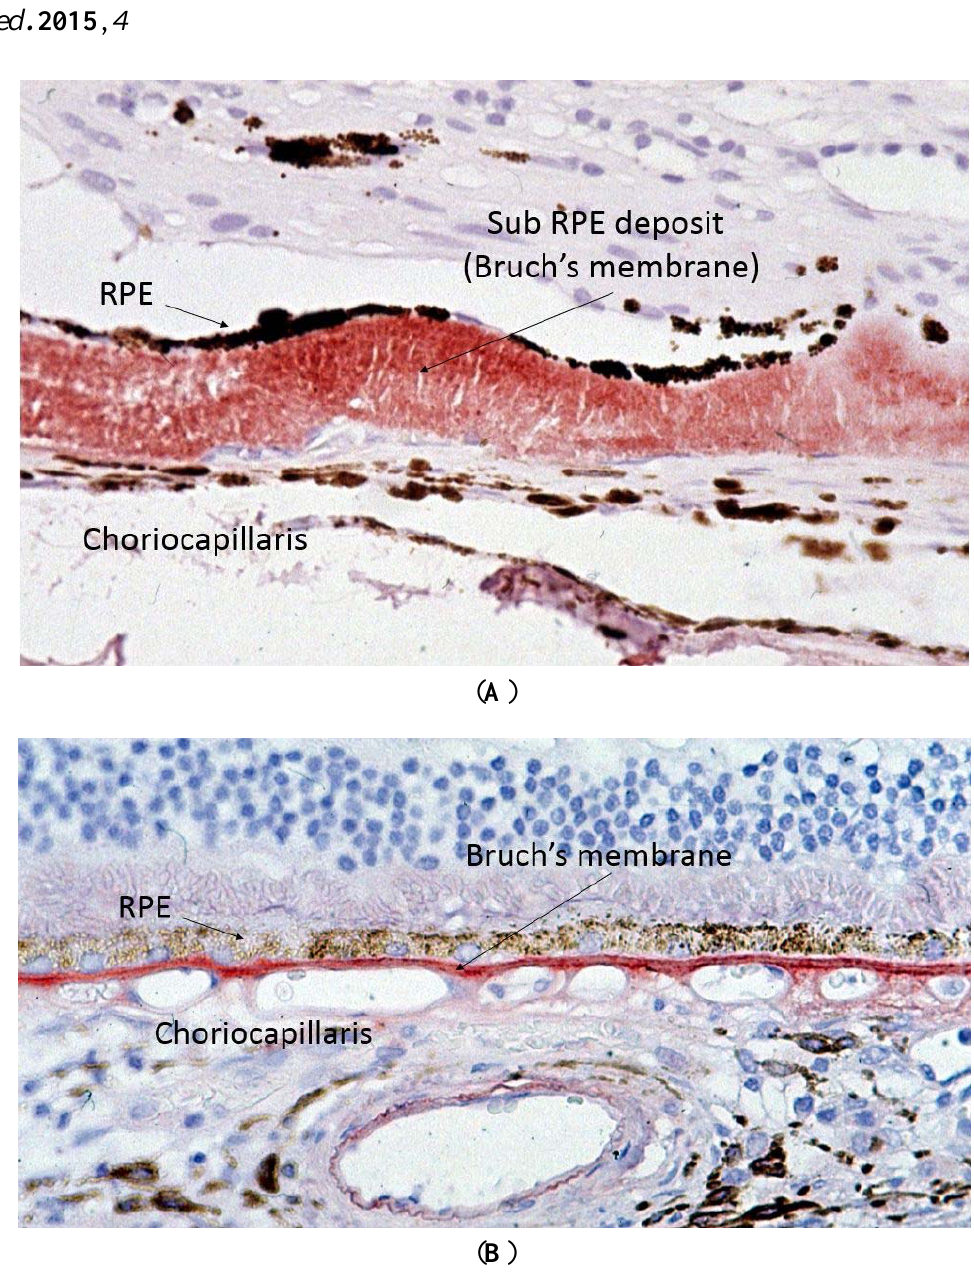
Figure 3. Light microscopy of Sorsby’s fundus dystrophy ( A ) showing extensive thickening of the Bruch’s membrane up to 30 microns as compared to normal ( B ) Bruch’s membrane thickness of one to two